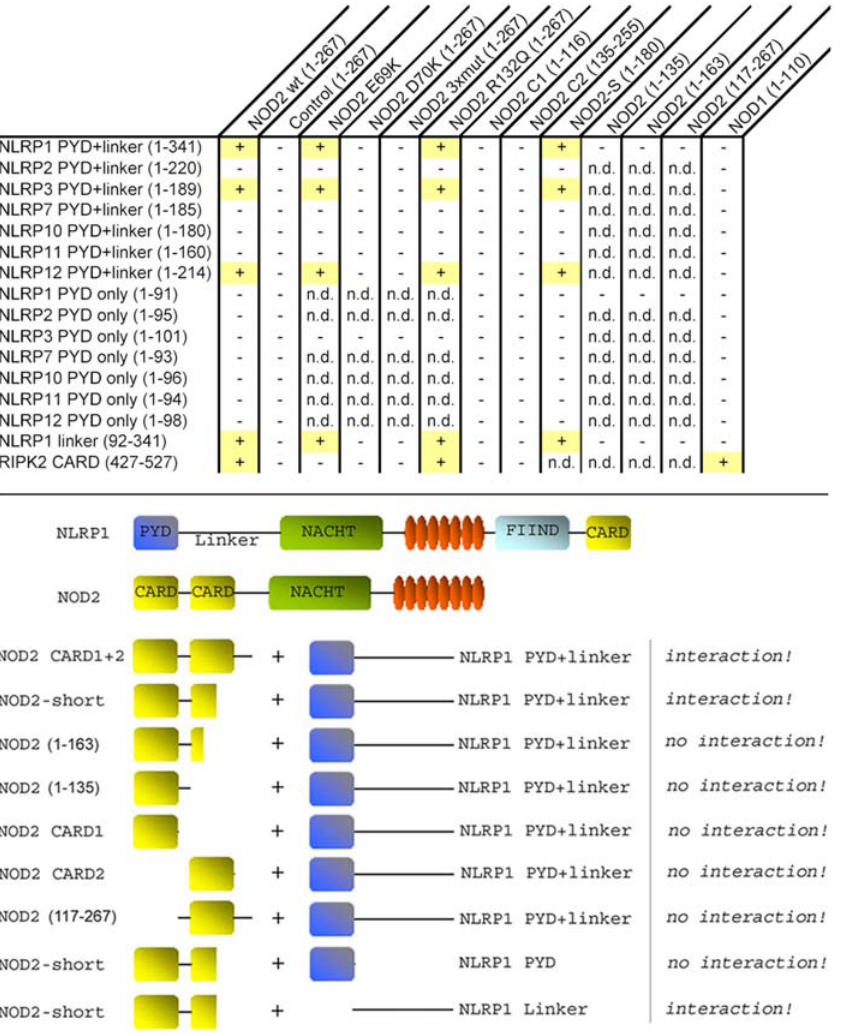
Figure 6. NOD2 interaction with distinct NLRP members. Upper panel , A ‘‘ + ’’ indicates an interaction, ‘‘ 2 ’’ symbolizes no interaction (n.d.: not done). A short isoform of NOD2 (NOD2-S, residues 1–180), maintains the interaction with NLRP1, -3, and -12. Furthermore, a linker region within NLRP1 (residues 92–341) proved sufficient for interaction with NOD2. Lower panel , Schematic illustration of particular NOD2/NLRP1 constructs and their respective interactions. FIIND: Function to find